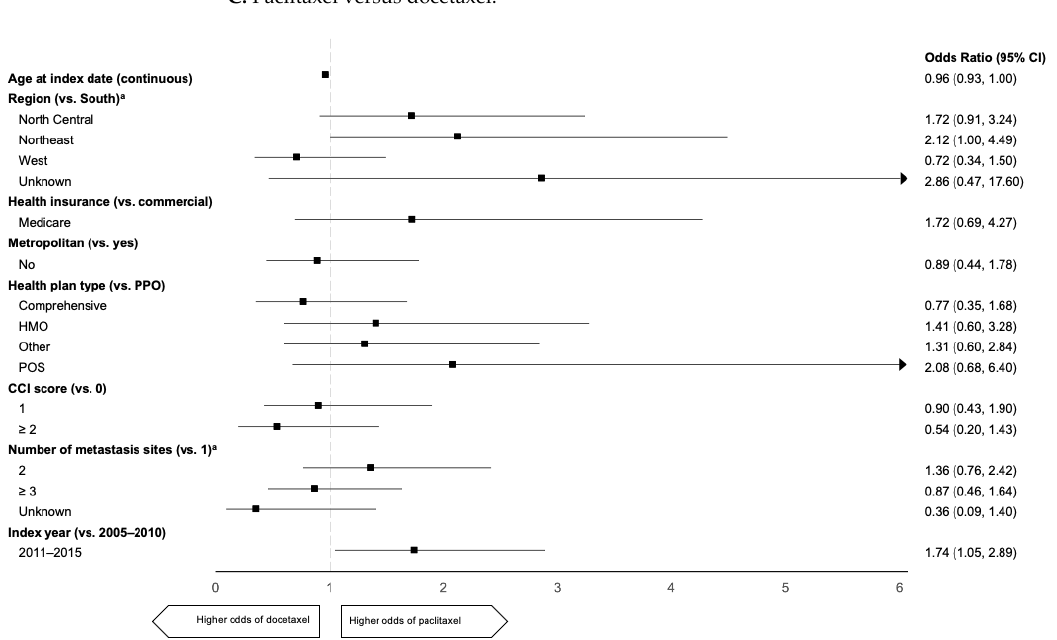
Comorbidity Index, HMO : health maintenance organization, mTNBC metastatic triple-negative breast cancer, POS : point of service, PPO : preferred provider organization. Arrowheads indicate a CI wider than the x axis. a Unknown categories are not shown because of unstable estimates from small sample sizes.